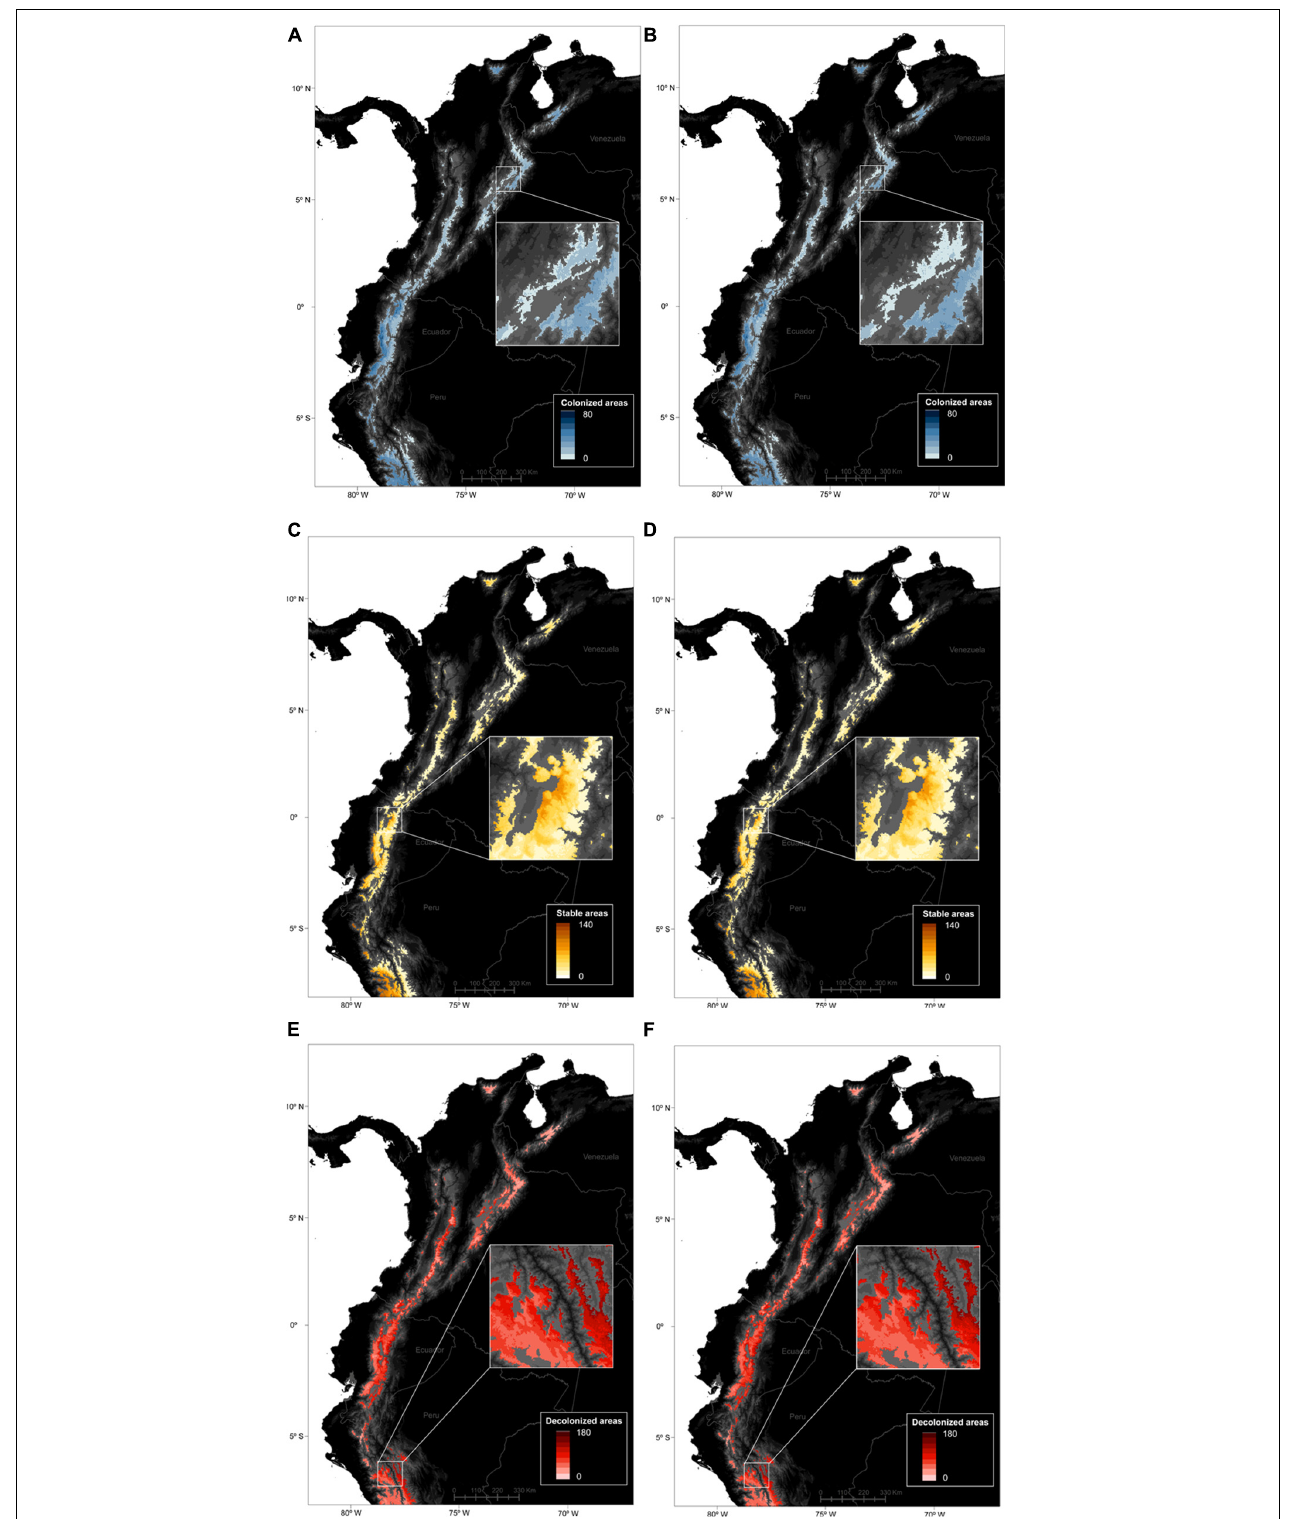
FIGURE 4 | Predicted spatial patterns of gained (A,B) , stable (C,D) , and lost areas (E,F) for 664 páramo plant species between 2010 and 2070, according to the moderate – RCP45 (A,C,E) and severe – RCP85 (B,D,F) climate change scenarios. A raster cell value accounts for the number of species predicted to have occupied the cell in 2070 only (A,B) , over the 2010–2070 timeperiod (C,D) , and in 2010 only (E,F) , and averaged over the 5 GCMs considered.